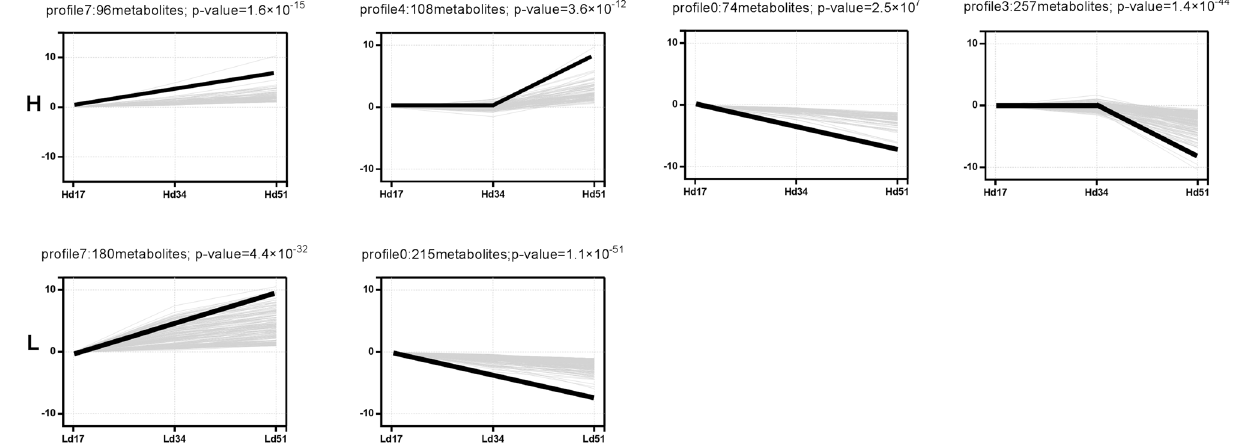
Figure 5. Patterns of metabolite expressions in the two strains. In each box, the thin gray line represents a metabolite expressed in this pattern, and the thick black line represents the expression trend of all metabolites in this pattern. The number of metabolites for this pattern and its P-value are indicated on the pattern box.